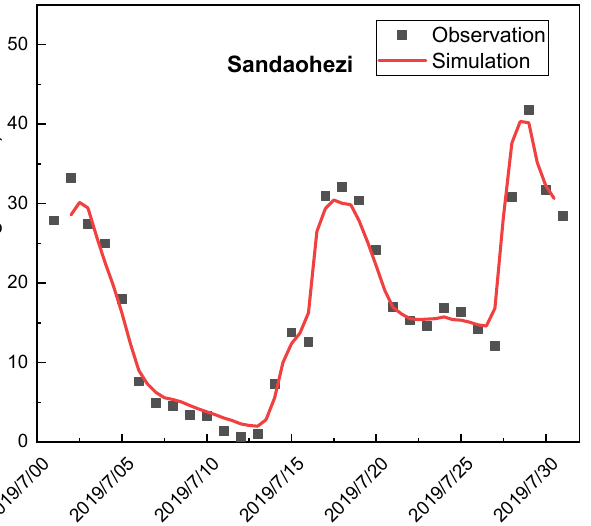
Figure 4. Comparison between simulated and measured discharge values of Sandaohezi hydrological station.